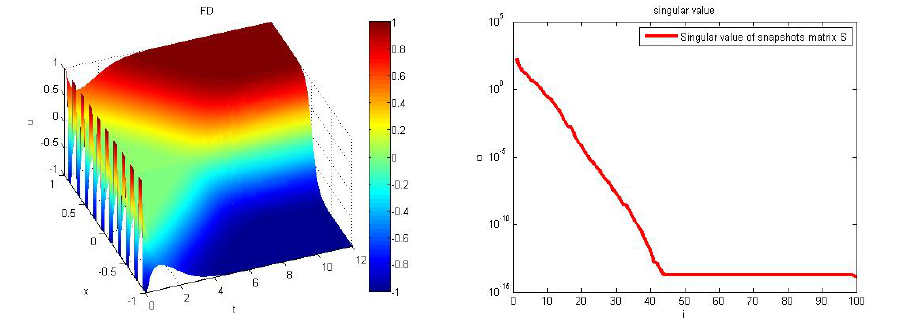
Figure 1. Solution of the FD full-order system for Allen–Cahn equation with (cid:101) = 0.01 and the corresponding singular values of the snapshot matrix S from SVD using POD basis.